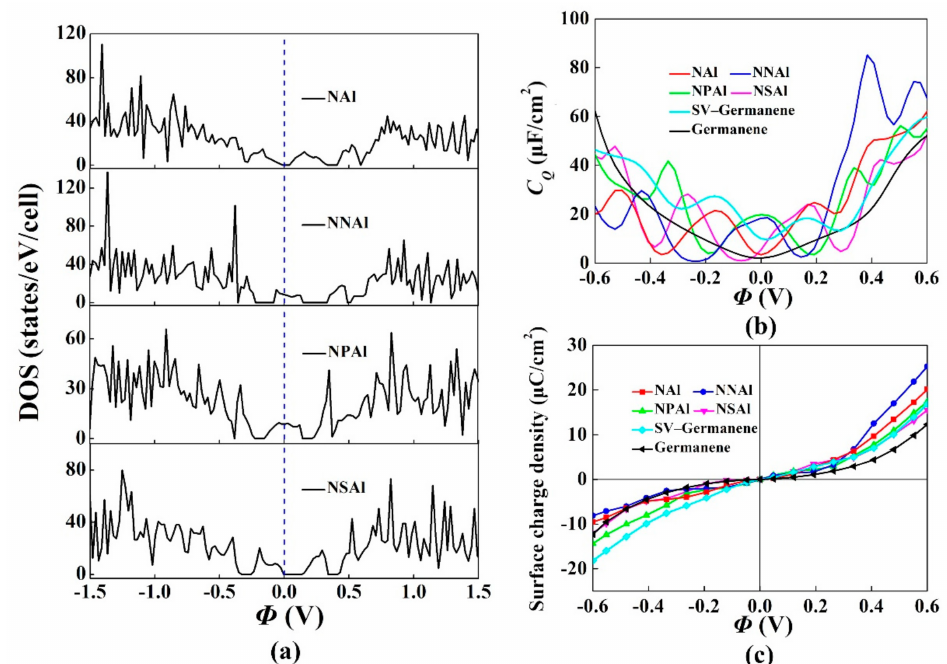
Figure 9. ( a ) Density of states (DOS) of single-vacancy germanene co-doped with N/P/S/Al; ( b ) Cal- culated quantum capacitance of the N/P/S/Al co-doped with single-vacancy germanene; ( c ) Surface charge density vs. Φ between − 0.6 V and 0.6 V.